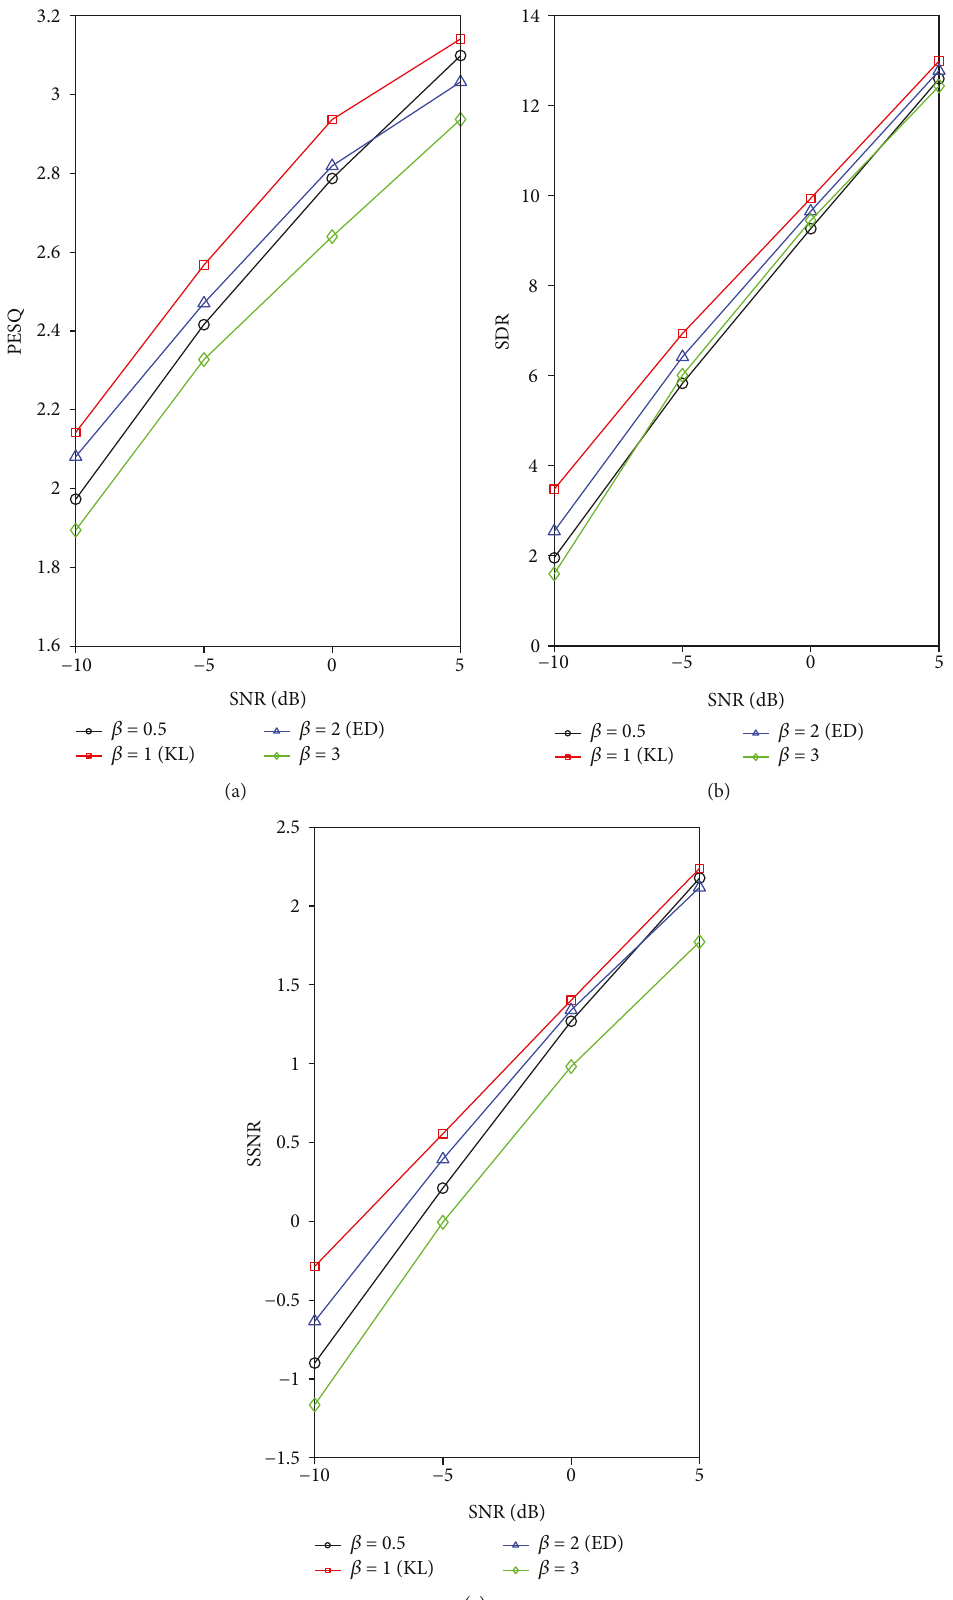
Figure 6: PESQ, SDR, and SSNR scores for the di ff erent divergence values from Factory1 noise at di ff erent SNR